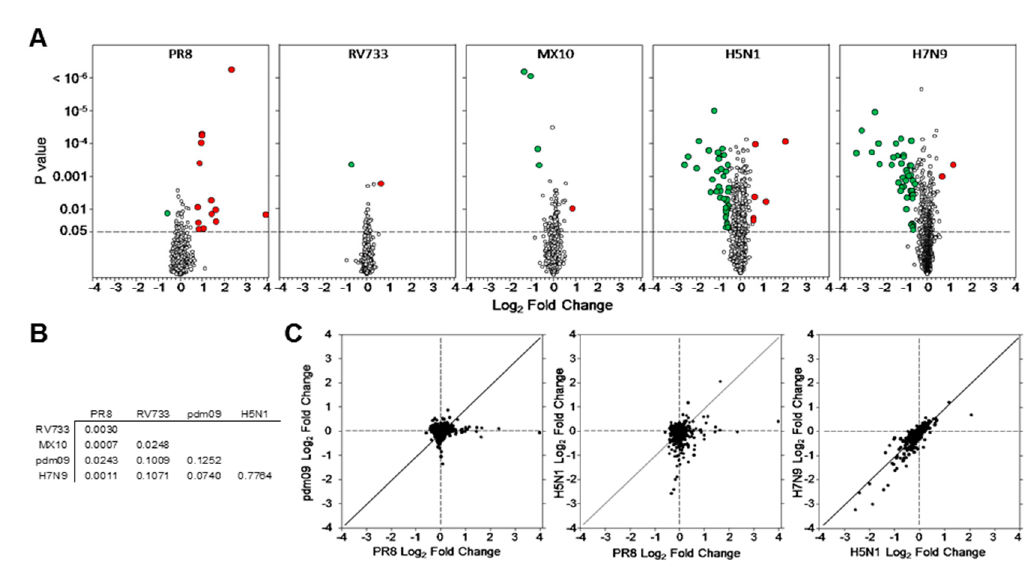
Values represent protein fold-changes compared to mock-infected. Fold-changes with significance <0.05 and with proteins significantly upregulated ≥ 1.50-fold are indicated in red, and proteins significantly downregulated ≤ 0.666-fold are indicated in green. Proteins sorted first by upregulation and from left-most virus column to right-most; then sorted by downregulation from left to right.